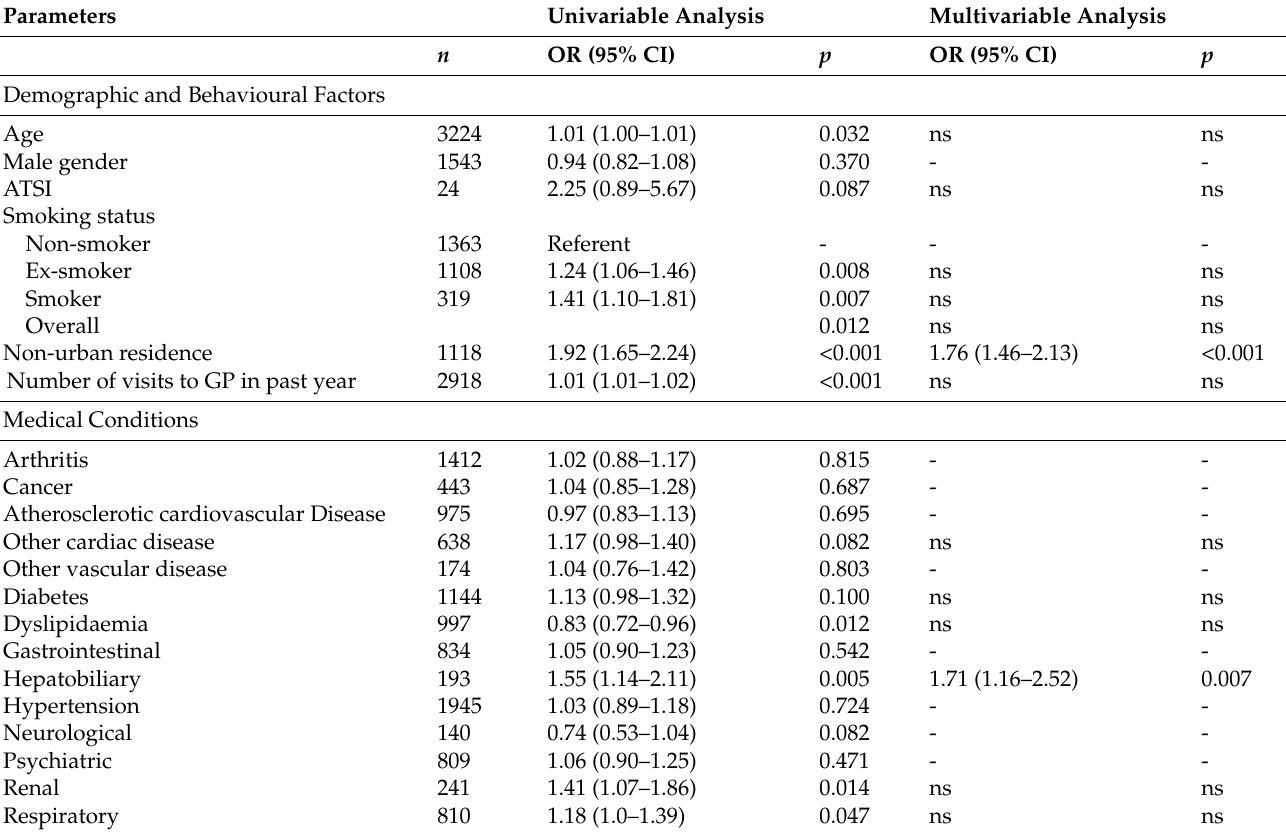
Table A9. Association of on-treatment C-reactive protein levels with patient factors in the ePBRN